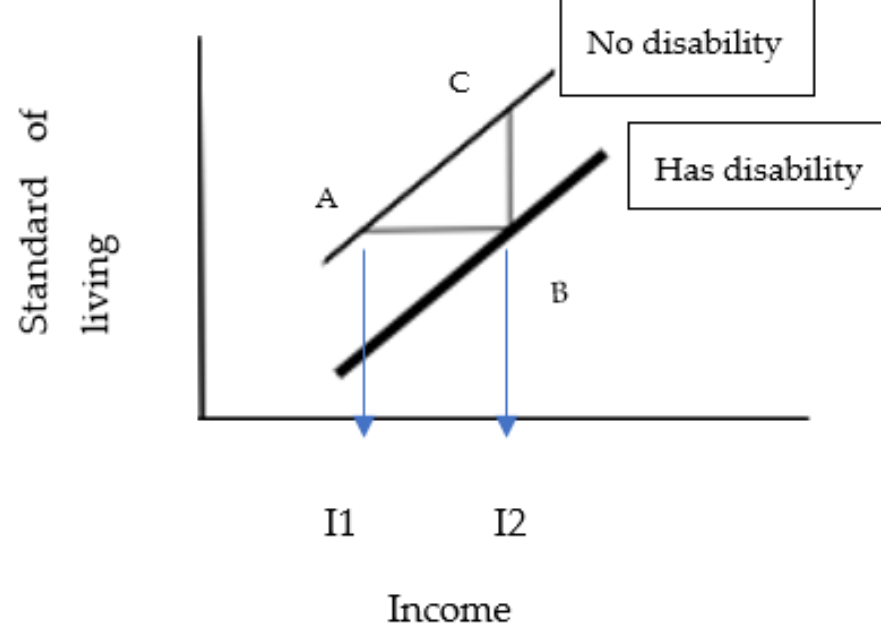
Figure 1. Relation Between Standard of Living and Income. Zaidi and Burchardt formulate the standard of living approach as.